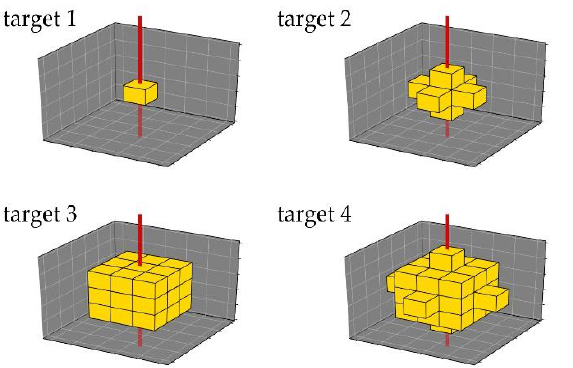
Figure 2. All four different targets to simulate XFI-scans in the thorax. Shapes shall represent a tu- mor or inflammation at different sizes and consist of voxels of lung-tissue, to which certain amounts of gold were added. In reality, such an area would have a round shape; targets follow voxel geom- etry of voxel phantom, and are thus cubic, depending on their size. Incident beam ( red ) hits them orthogonally, thus between target 2 and target 3, amount of target voxels in beam volume does not change.